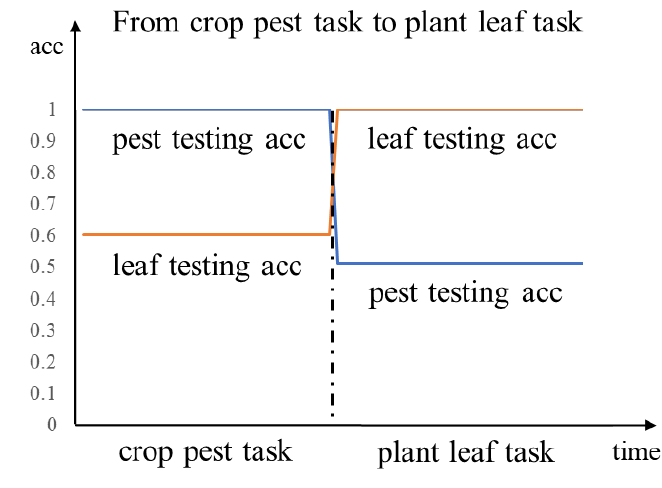
Figure 12. The testing accuracy of the first case.